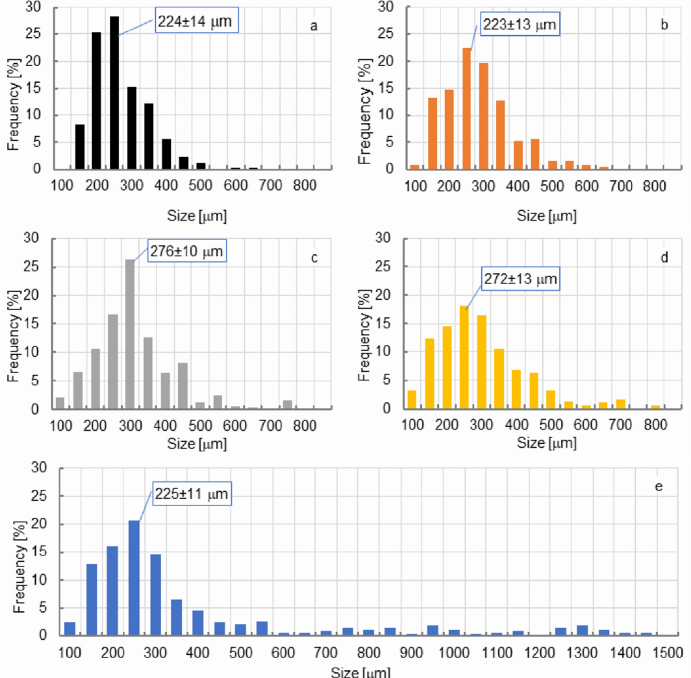
Figure 7. Cell size and cell size distribution of PUR foam depending on wood particle (WP) content: ( a ) control; ( b ) 5%; ( c ) 10%; ( d ) 15%; ( e ) 20%